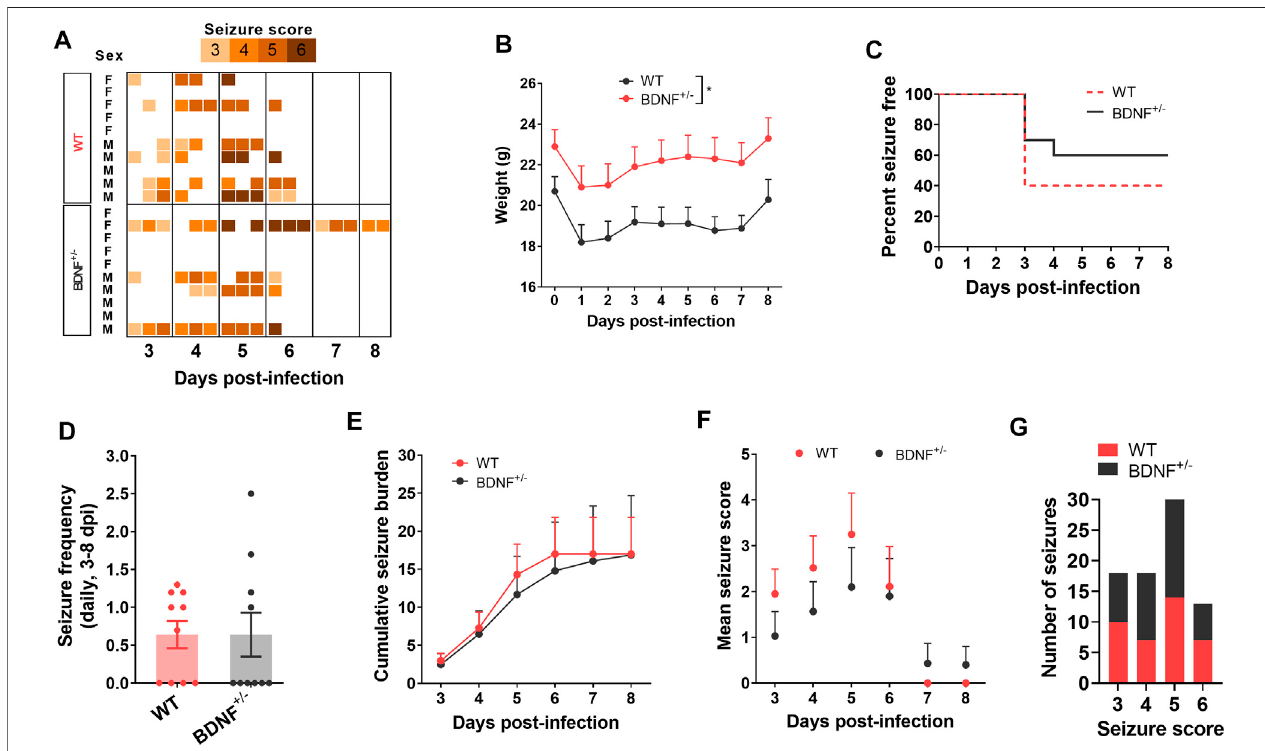
FIGURE 5| No difference in TMEV-induced acute seizures between wild type (WT) and BDNF +/ − C57BL/6J mice. (A) Heatmap shows all acute seizures observed based on their severity score for each mouse between 3 – 8 days post-infection (dpi). Seizures were induced by handing and the severity was scored three times a day with at least 2 h of undisturbed period between two observation sessions. (B) Average weight of mice in each group during acute infection period. (C) This panel shows thepercentageoftotalinfectedmiceineachgroupthatremainedseizurefreeateachdayuntil8dpi.Noneofthemicedevelopedseizuresbefore3dpi. (D) Average numberofseizuresdailybetween3-8dpiisplottedforeachmouse. (E) Averagecumulativeseizureburden,whichiscalculatedasameanofthesummationofallseizure scores for each mouse over time, compares seizure severity between WT and BDNF +/ − mice during acute infection period. (F) Mean seizure score at each day is compared. (G) It shows the total number of seizures based on their severity score.